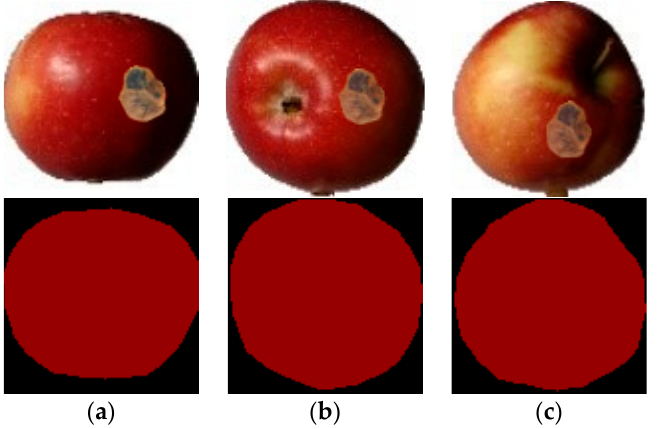
Figure 5. Apple images with different rot positions and their labels. ( a ) View without the stalk or calyx. ( b ) View of calyx. ( c ) View of stalk.